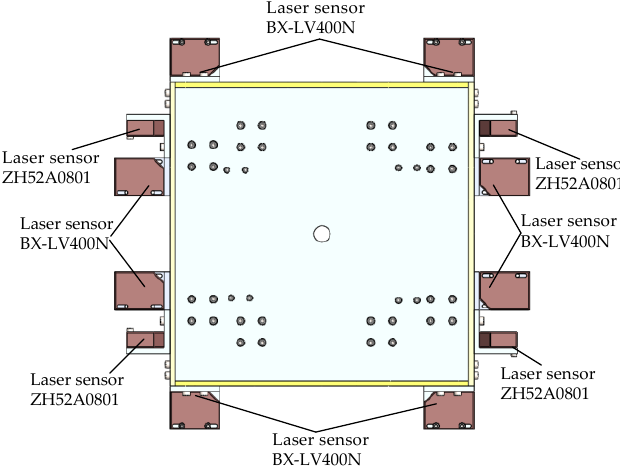
Figure 7. Sensor and controller on the 6-DOF platform actuator.